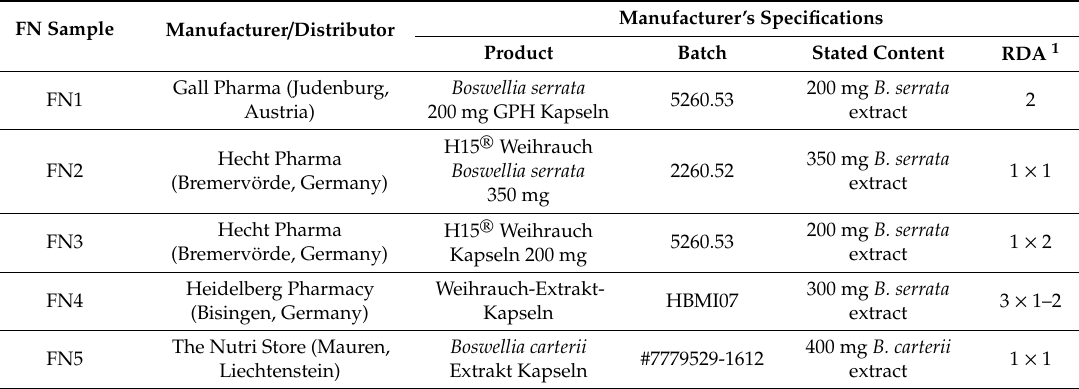
Table A1. Frankincense nutraceuticals (FNs) analyzed in the